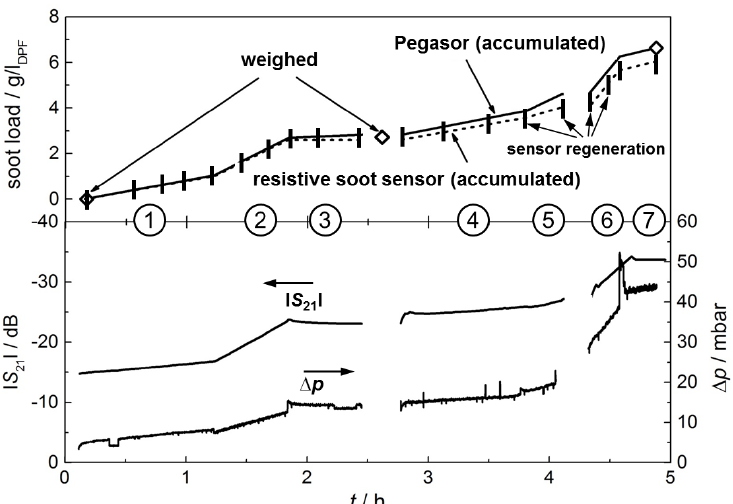
Figure 4. Upper graph: soot load of the DPF, determined by weighing (open squares), with the Pegasor sensing device (solid line, corrected), and with the resistive soot sensor (dashed line, corrected). The vertical bars indicate regeneration events of the resistive soot sensor. Lower graph: microwave-derived transmission parameters, | S 21 | in dB, and differential pressure, Δ p .